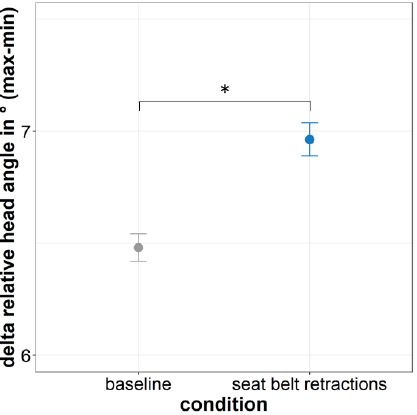
Figure 15. Means of delta relative head angle grouped by seat belt condition. Delta represents the deviation between the maximum and minimum head angle during a braking maneuver. Error bars display 95% confidence intervals. * p < 0.05.